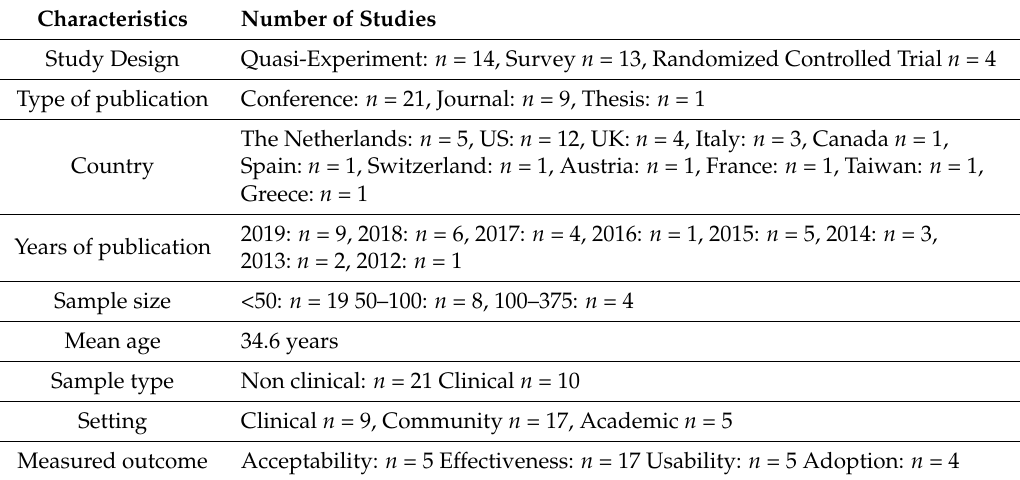
Table 2. Overall characteristics of the included